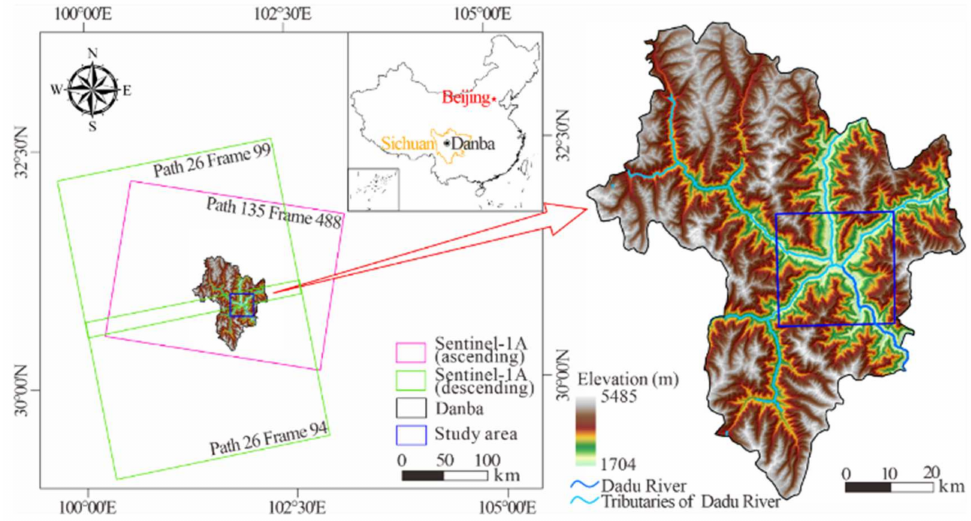
Figure 3. Location of the study area and coverage areas of SAR datasets.